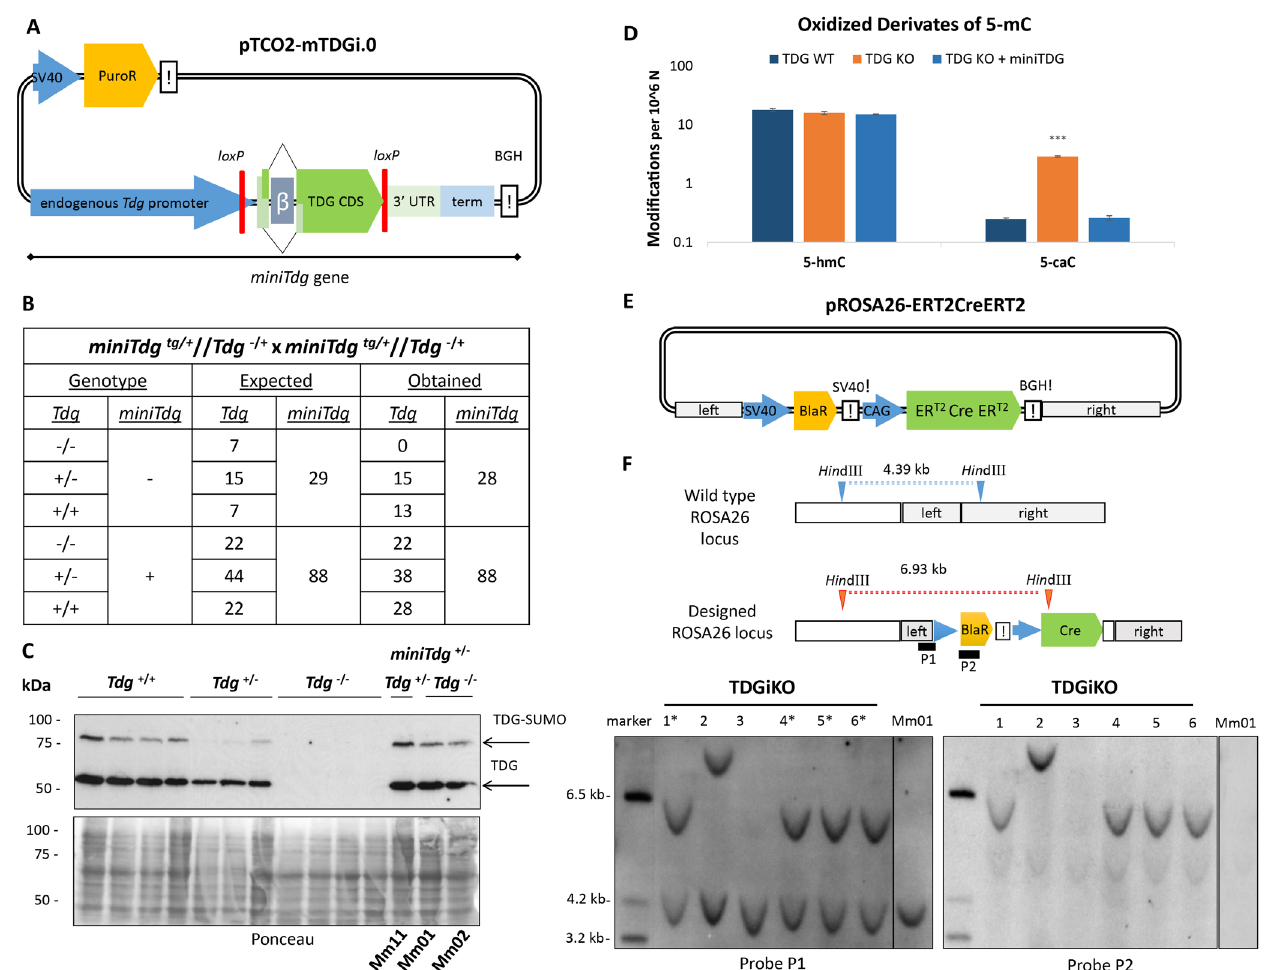
Figure 1. miniTdg complementation of Tdg -/- mice and mESCs. ( A ) Synthetic miniTdg gene on the plasmid integrated to a random genomic locus by pronuclear injection. miniTdg consisting of 6 kb endogenous Tdg promoter, the Tdg coding sequence (CDS) including a chimeric splice donor ( Tdg exon 1 of transcript variant 2 NM_172552.4, rabbit β-globin intron), to allow for alternative splicing, 3 kb of the 3’ untranslated region (3’ UTR) and terminator (term) of Tdg , and the bovine growth hormone terminator sequence (BGH!). loxP sites are indicated in red. ( B ) Expected and obtained genotype distribution in offspring (n=116) from crosses of heterozygous mice. ( C ) Top: Immunoblot for TDG of whole-cell SDS-extracts from derived ESCs with different genotype. Bottom: Loading control by Ponceau staining of the membrane. ( D ) Accumulation of oxidized 5-mC derivates measured by HPLC-MS/MS in ESCs with the indicated genotype. For each genotype, means and standard deviations of two independent clones with 1 or 2 repeated measurements are shown. Asterisks indicate p -values of Student’s t-test, compared to TDG WT: *** p -value < 0.001. ( E ) Scheme of the targeting construct pROSA26-ERT2CreERT2 for the ROSA26 locus with the tamoxifen-inducible Cre recombinase (Matsuda & Cepko, 2007). ERT2-Cre-ERT2 expression is under the control of the synthetic cytomegalo-virus/chicken-actin/beta-globin promoter (CAG). Homology arms for ROSA26 targeting are indicated in light grey. A blasticidin resistance cassette (BlaR) for positive selection is under the control of the SV40 promoter and terminator. ( F ) Predicted restriction pattern of ROSA26 WT and integration events (top) and fragments detected by Southern blotting (bottom). Left: The hybridization probe (P1) locating to the left ROSA26 homology arm detected a genomic fragment of 6.9 kb. The 4.4 kb fragment represents the wild-type ROSA26 allele. Right: Detection of possible off-target events using a second probe (P2) locating to the blasticidin selection marker within the targeting construct. See Underlying data for the raw data behind this figure (Schwarz, 2020). ESCs, TDG protein levels were similar to those in wild-type functional in complementing the developmental defects and ESCs (Figure 1C), indicating that the miniTdg gene is regu- lethality of homozygous Tdg tm1Psch KO embryos (Cortázar et al ., lated as the endogenous Tdg . Furthermore, no silencing of the 2011; Cortellino et al ., 2011). MiniTdg complemented mice transgene was noticed over several generations of animal breed- were healthy and fertile with normal lifespan. ing or culturing of ESCs. To assess functional integrity at the molecular level, we measured the accumulation of oxidized Three ESC populations were then derived from male blastocysts 5-methylcytosine (5-mC) derivates, 5-hydroxymethylcytosine from crosses of miniTdg tg/tg // Tdg -/- with Tdg +/- mice ( Extended (5-hmC) and 5-carboxylcytosine (5-caC), the substrate data , Table S2: Mm11, Mm01, Mm02) (Schwarz, 2020). In these